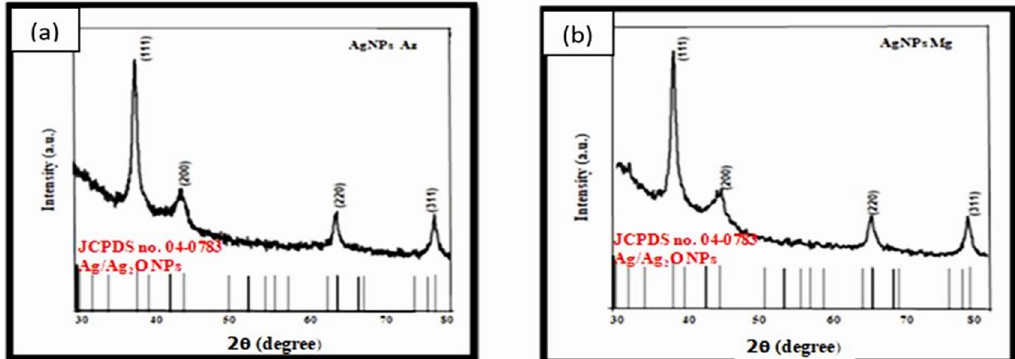
Figure 5. XRD pattern of the ( a ) A-AgNPs and ( b ) M-AgNPs synthesized from tree leaf